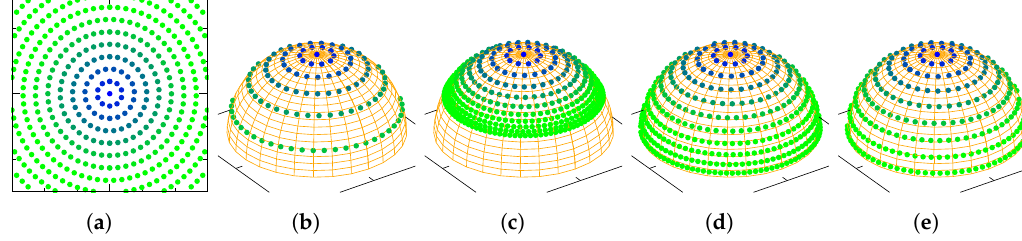
Figure 2. Points in the Euclidean space with e 3 = 0 are mapped with points in the manifold through each chart inverse ϕ − 1 . ( a ) R 2 ; ( b ) O; ( c ) RP; ( d ) MRP; ( e )